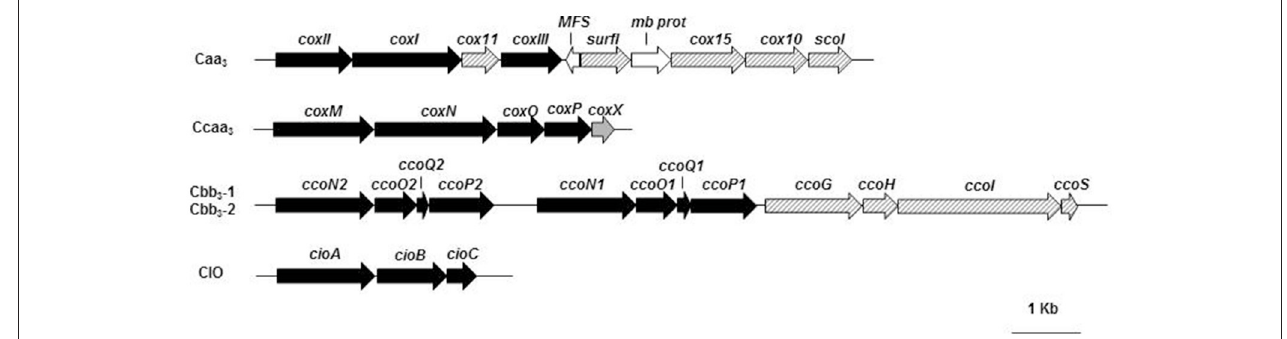
FIGURE 1 | Organization of the terminal oxidase gene clusters in KF707: cox , encoding for cytochrome c oxidases of caa 3 type ( coxI-II-III ) and ccaa 3 type ( coxMNOP ); cco, encoding for gene products involved in the synthesis and assembly of two cytochrome c oxidases of cbb 3 type ( ccoN1O1Q1P1 and ccoN2O2Q2P2) ; cio , gene cluster for the quinol oxidase CIO ( cioABC ). Genes (listed in Table S2) are represented by arrows and by different colors or stripes: black, functional genes; dashed stripes, genes for cytochrome biogenesis; gray, cytochrome c oxidase accessory membrane protein (CoxX); white, genes supposedly not directly related with the gene clusters under analysis. Full names and abbreviations used: MFS, Major Facilitator Superfamily permease; mb prot, membrane protein.